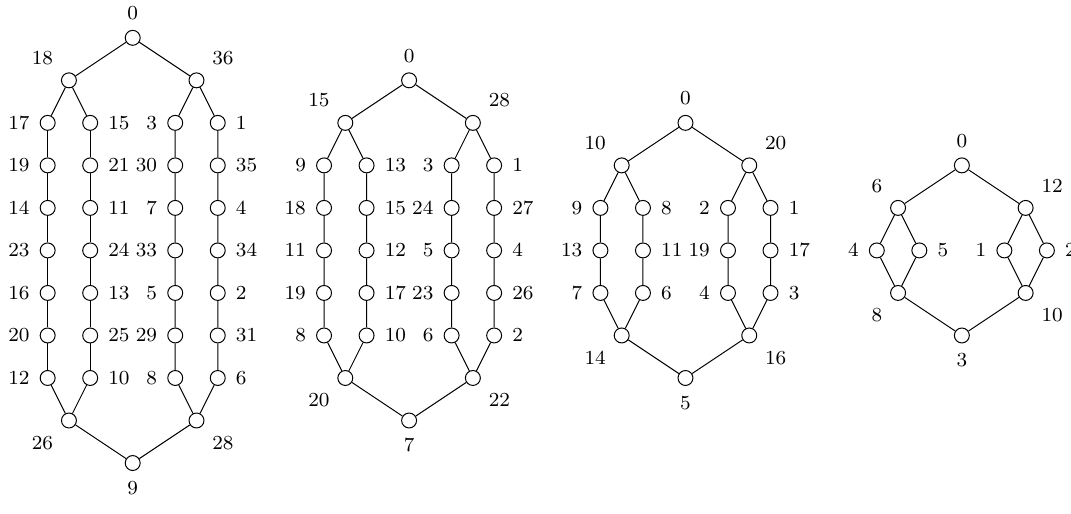
Figure 5: Parallel α -graphs obtained using modified